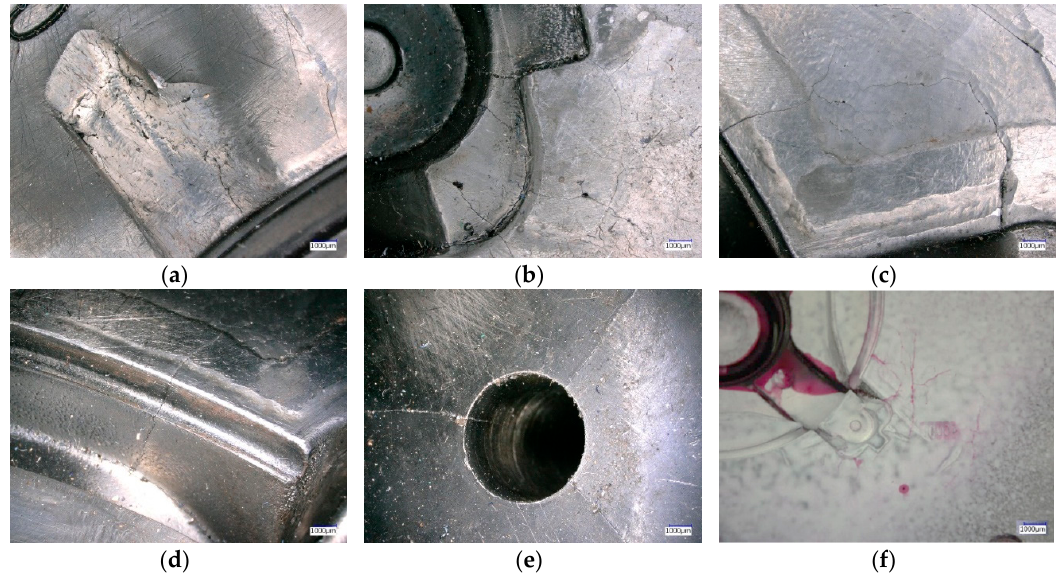
Figure 1. ( a – f ) Detail of damage on different locations of the surface of high-pressure casting die after 800,000 working cycles.